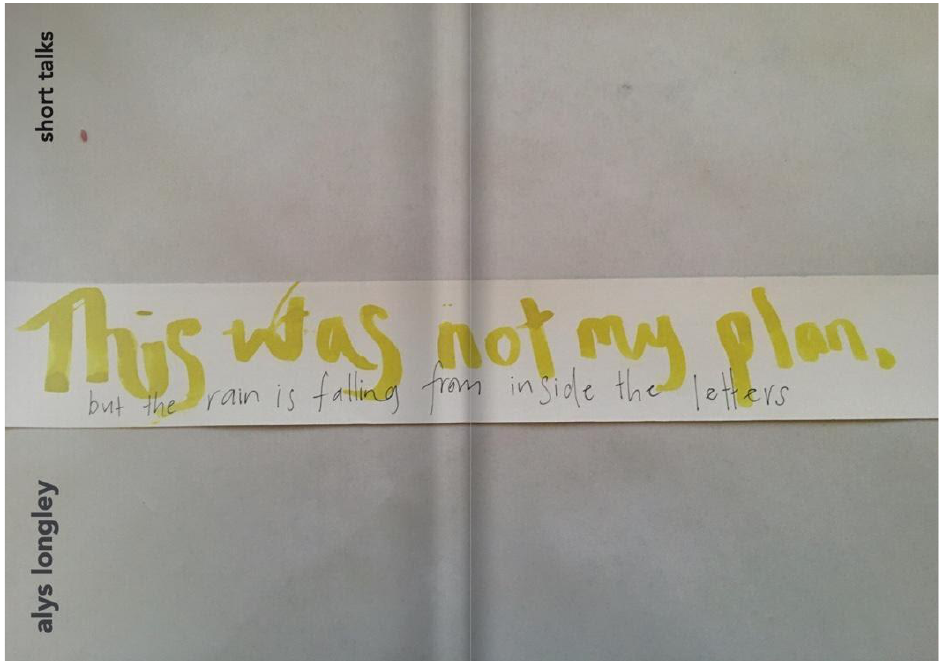
Figure 4: “This was not my plan, but the rain is falling from inside the letters” Alys Longley Language is an Intangible Bridge artist